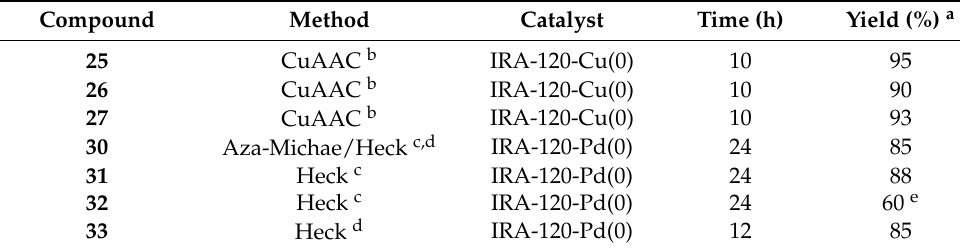
◦ C. d 90 ◦ C. e 30% of compound 2 O, 70